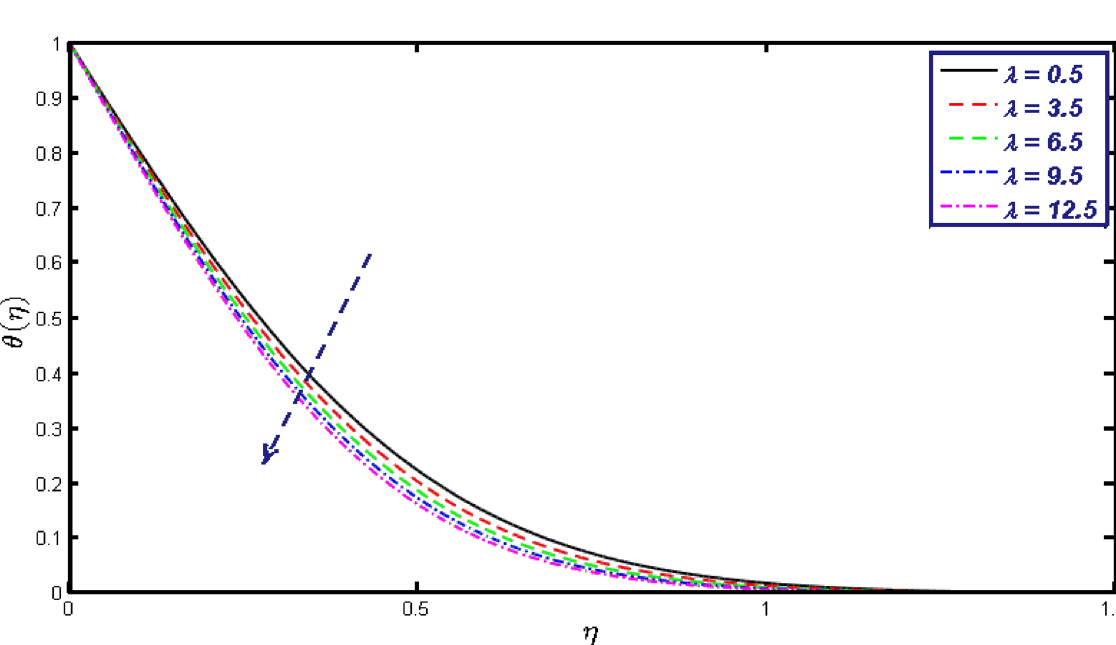
Figure 10. θ(η) field for different values of (cid:31)